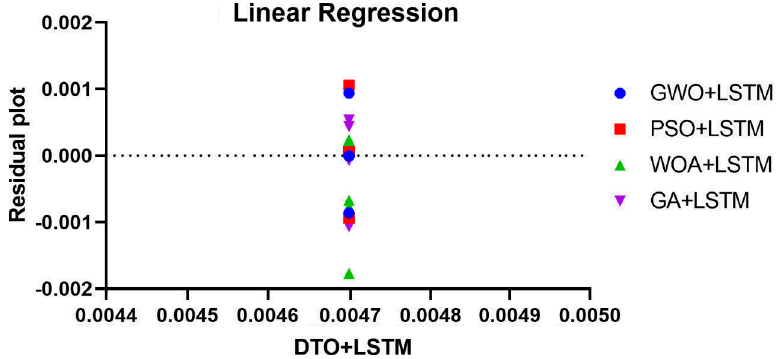
Figure 12. The regression analysis of the achieved results. Table 14. Results of the linear regression analysis applied to the proposed approach records and compared to the other four competing